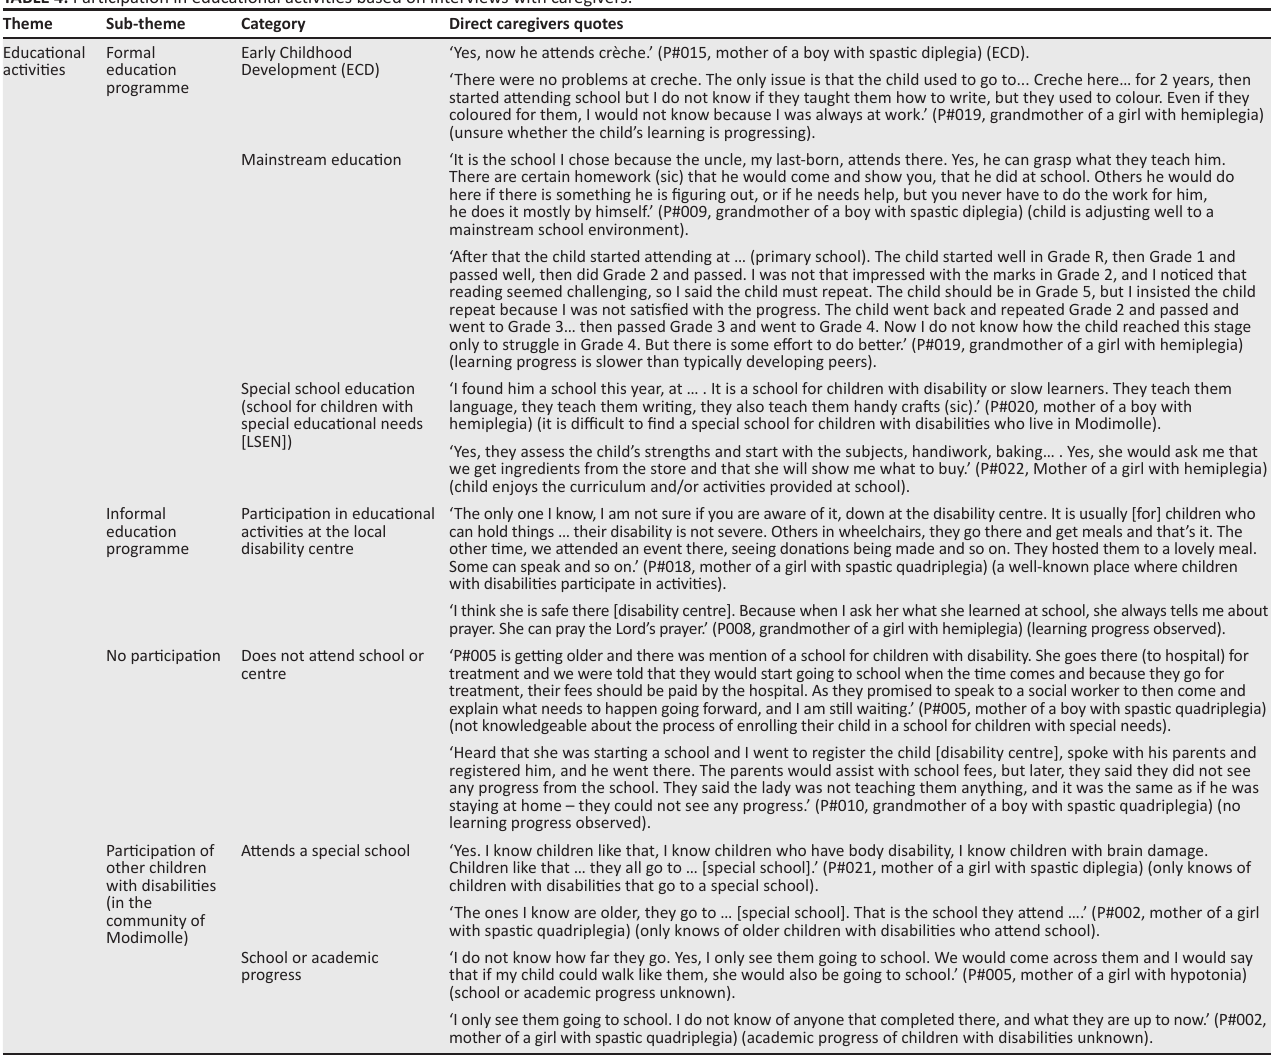
TABLE 4: Participation in educational activities based on interviews with